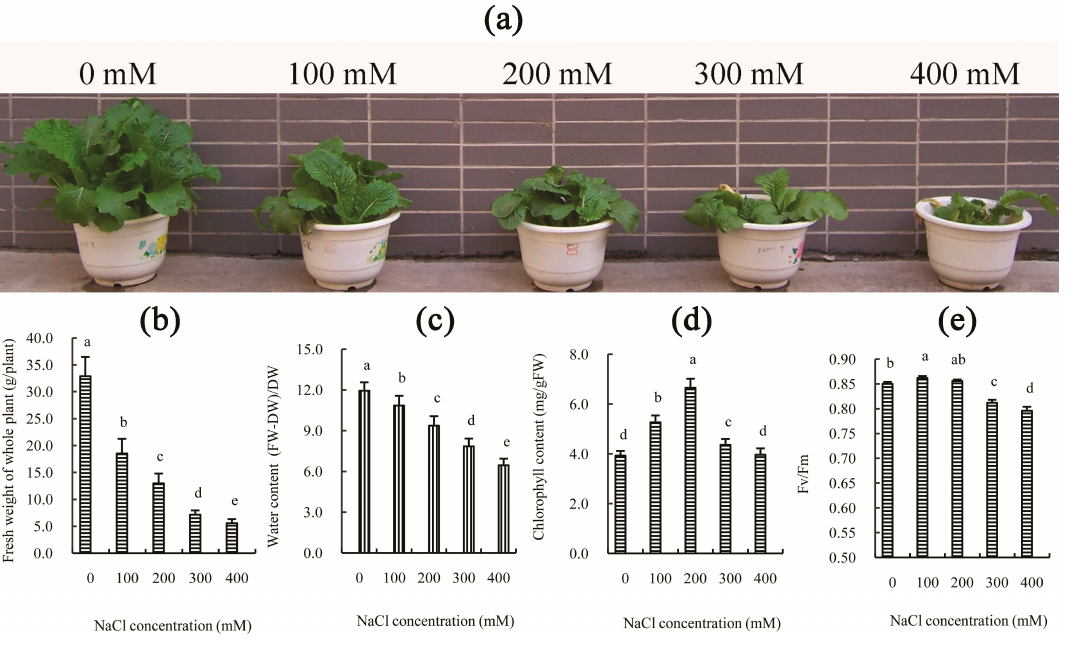
Figure 1. Effects of different concentrations of NaCl on: the growth of whole plants ( a , b ); water content ( c ); chlorophyll content ( d ); and photochemical efficiency (Fv/Fm) of PSII ( e ). All parameters were measured on the Day 30 after salt treatment. The values are the means (±SD) of 15 replicates. Means followed by different letters indicate significant differences ( p < 0.05). Table 1. Effect of salt-treatment on photosynthetic indexes of Chinese cabbage. The values are the means (±SD) of 10 replicates.